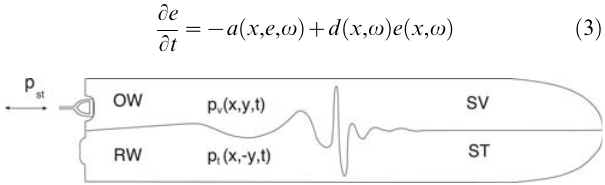
Figure 1. Uncoiled cochlea. Emergence of a travelling wave on the BM due to a sinusoidally varying sound wave with stapes amplitude p st (OW: oval window, RW: round window, ST: scala tympani, SV: scala